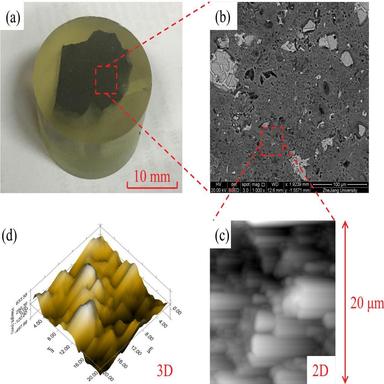
(a) A readily encased HCP specimen after grinding and polishing, (b) a typical BSE image of local area, and (c) 2D and (d) 3D SPM tests showing the surface roughness in a down-scaled area.